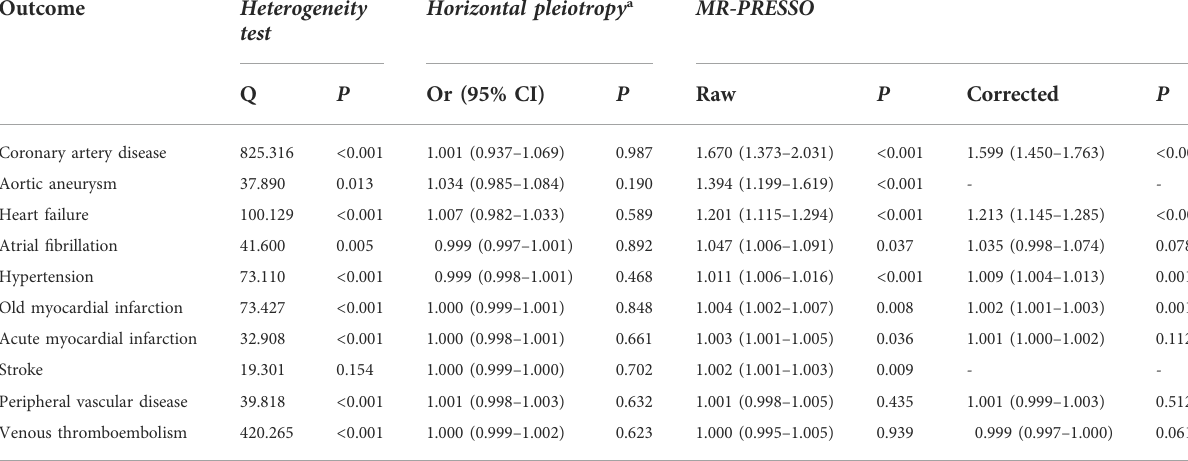
CI, con fi dence interval; OR, odds ratio; WHR, Waist-to-hip ratio. a The MR-Egger intercept quanti fi es the effect of directional pleiotropy. p < 0.05 provides evidence that the exposure-associated single-nucleotide polymorphisms may in fl uence the outcome through other pathways than through